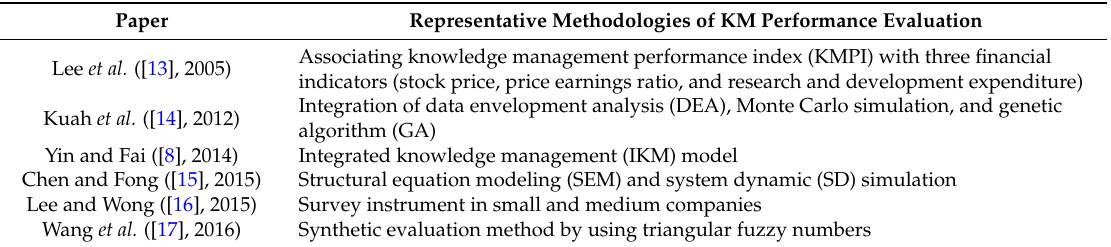
Table 1. A summary of the methodologies for KM performance evaluation in recent